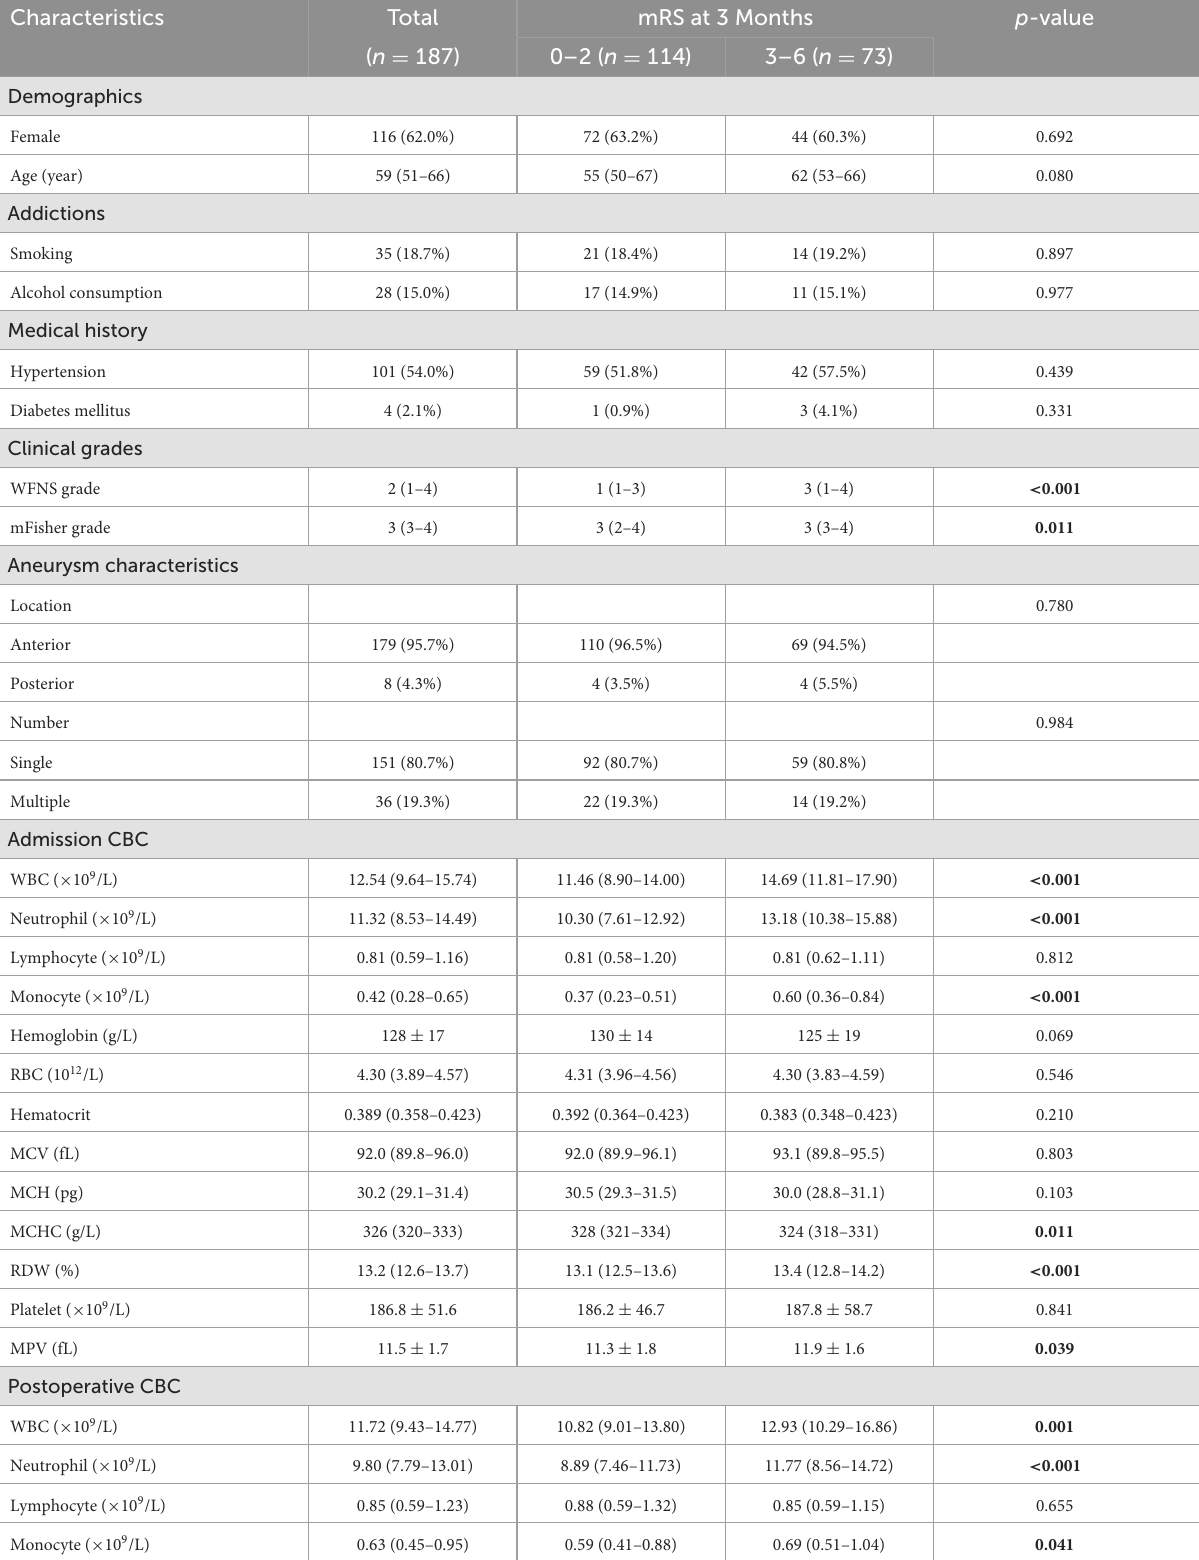
TABLE 1 Univariate analysis of baseline characteristics and CBC parameters associated with poor functional outcome at 3 months.